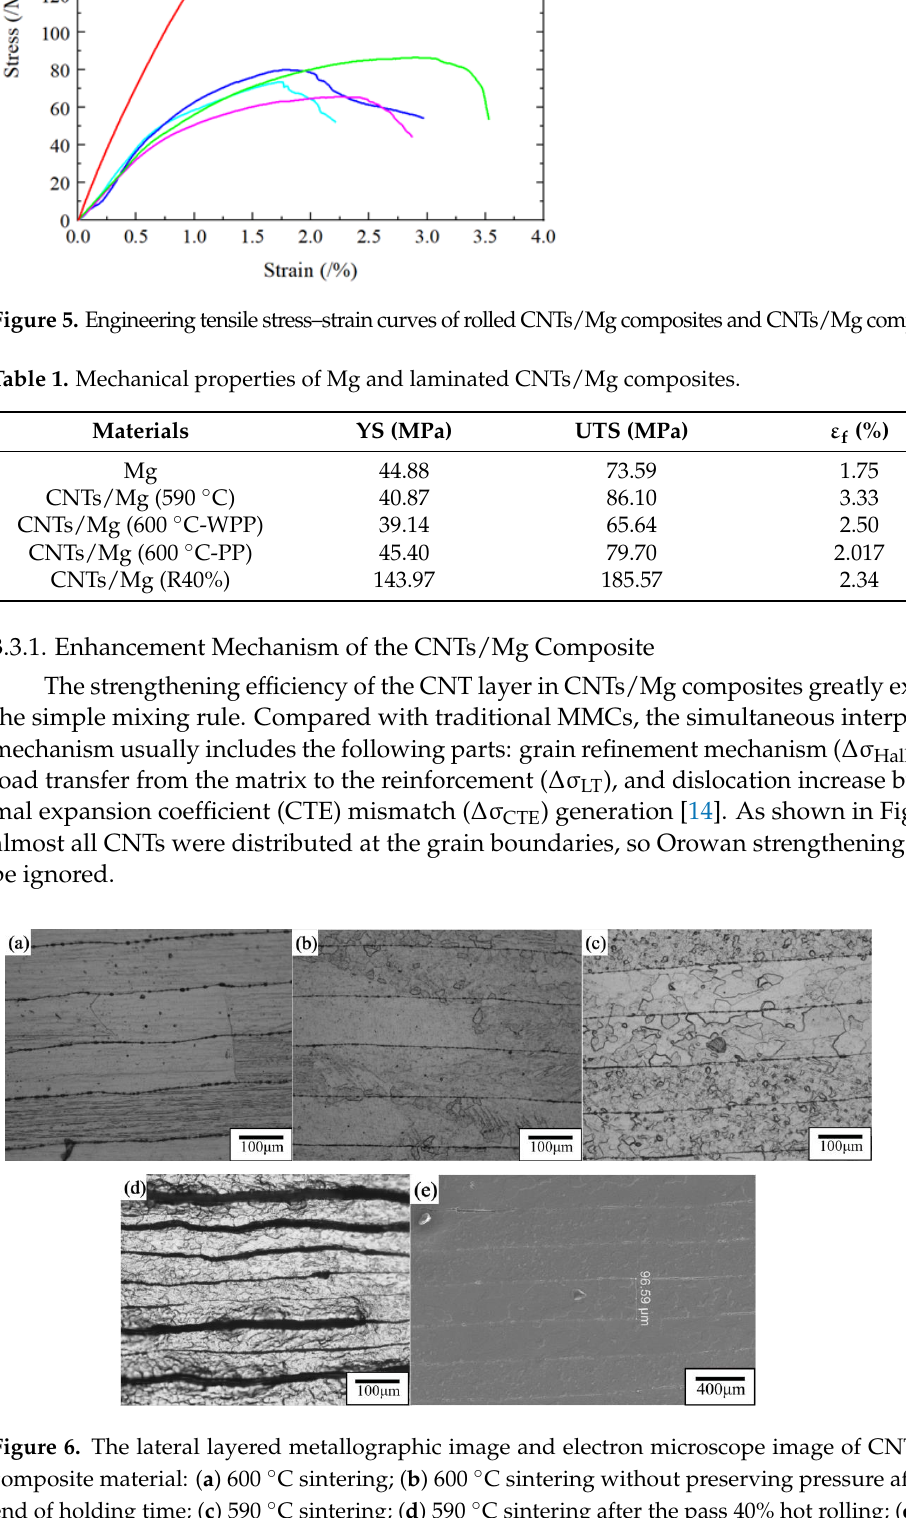
Figure 7. XRD pattern of the materials.